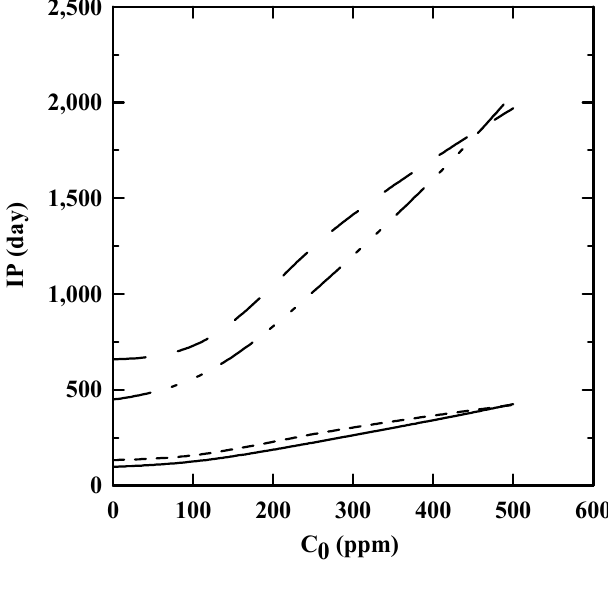
Figure 5. The predicted IP of the SNME and FFA-based biodiesel blend at 25 °C with C — and : EN 14,112 and EN 15,751, respectively, as predicted by the linear relationship between ln IP and T. and －－ : EN 14,112 and EN 15,751, respectively, as predicted by the reaction rate